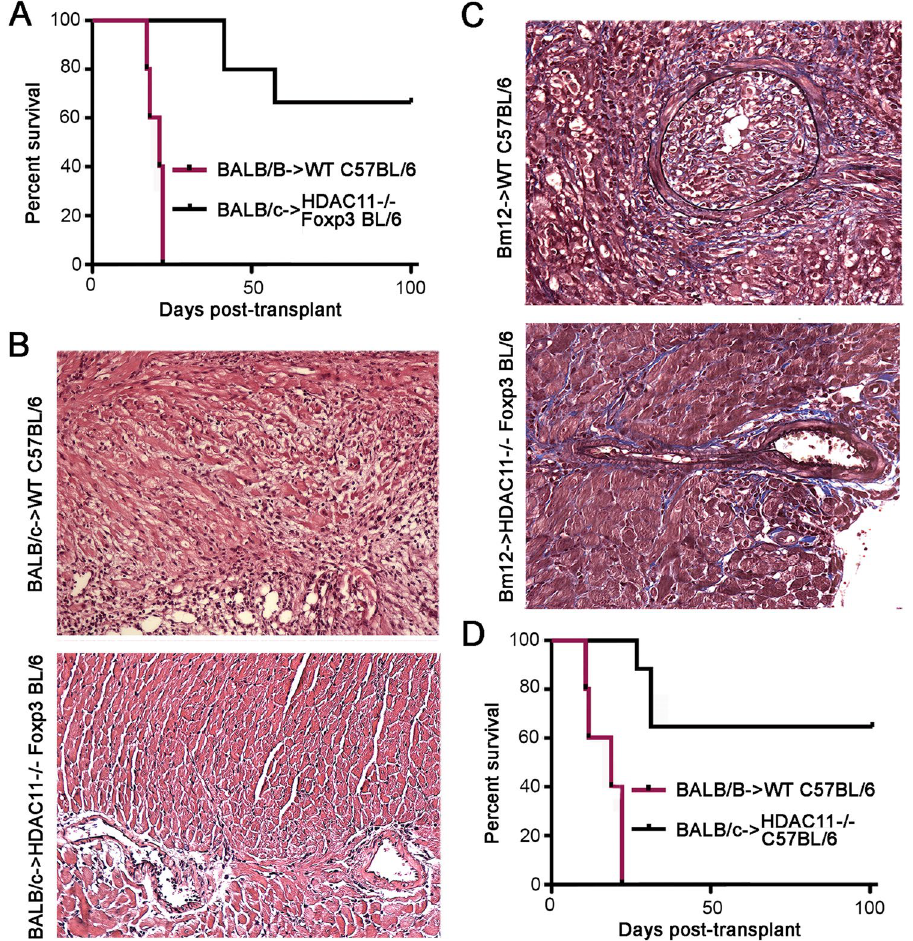
Figure 4. Effects of conditional or global HDAC11 deletion on cardiac allograft survival. ( A ) Compared to the acute rejection of BALB/c cardiac allografts in WT recipients, about two thirds of allografts in mice with conditional deletion of HDAC11 within their Tregs survived for > 100 days (p < 0.01, n = 6 allografts/group). ( B ) Histology (H&E) of corresponding cardiac allograft groups as shown in panel (A) when harvested at day 7 post-transplant; note the absence of graft infiltration and myocyte necrosis in HDAC11 − / − hosts compared to WT controls. ( C ) Histology of Bm12 cardiac allografts harvested at 30 days post-transplant from WT mice or mice with conditional deletion of HDAC11 within their Foxp3 + Treg cells, with a marked difference in the development of transplant arteriosclerosis (p < 0.001), myocyte injury and mononuclear cell infiltration (see Results for quantitative data on vessel scores for the 2 groups). ( D ) Compared to the acute rejection of BALB/c allografts in WT recipients, about two thirds of cardiac allografts in mice with global deletion of HDAC11 within their Tregs survived for > 100 days (p < 0.01, n = 10